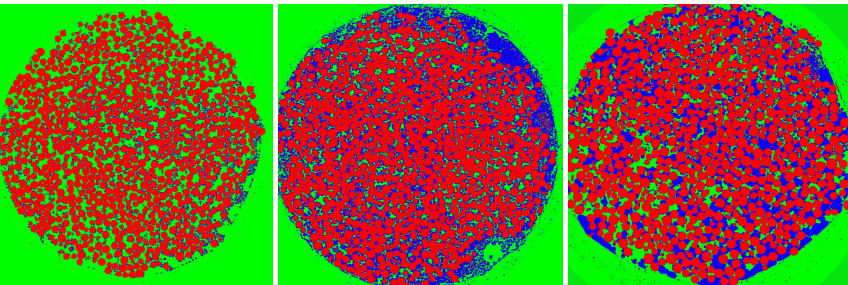
Figure 4. Distribution of the segmented phases, glass (in red), void (in green), and CaCO for the 3D experiments over selected cross sections of the three sample columns: slice #570 for the low mineralization ( left ), slice #477 for the medium mineralization ( center ), and slice #706 for the high mineralization ( right